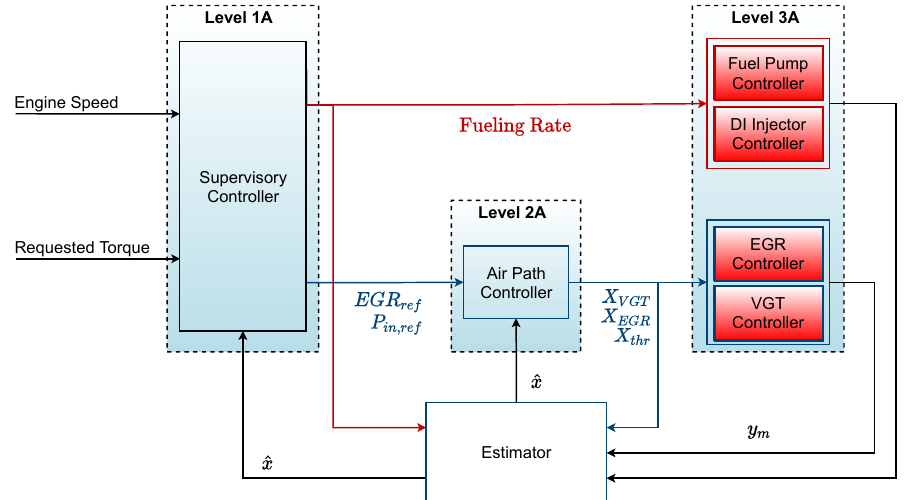
Figure 6. The architecture of a supervisory model predictive controller (L1A) and a nonlinear model predictive feedback controller L2A to minimize engine-out emissions (NOx, uHC) of a diesel fueled CI engine—This includes a three-level hierarchy ICE control based on topology II where the fueling rate input from L1A is applied directly to the engine, while the EGR rate ( X EGR ), EGR throttle ( X thr ), and VGT rate ( X VGT ) target generated by L1A are passed to the L2A controller (based on